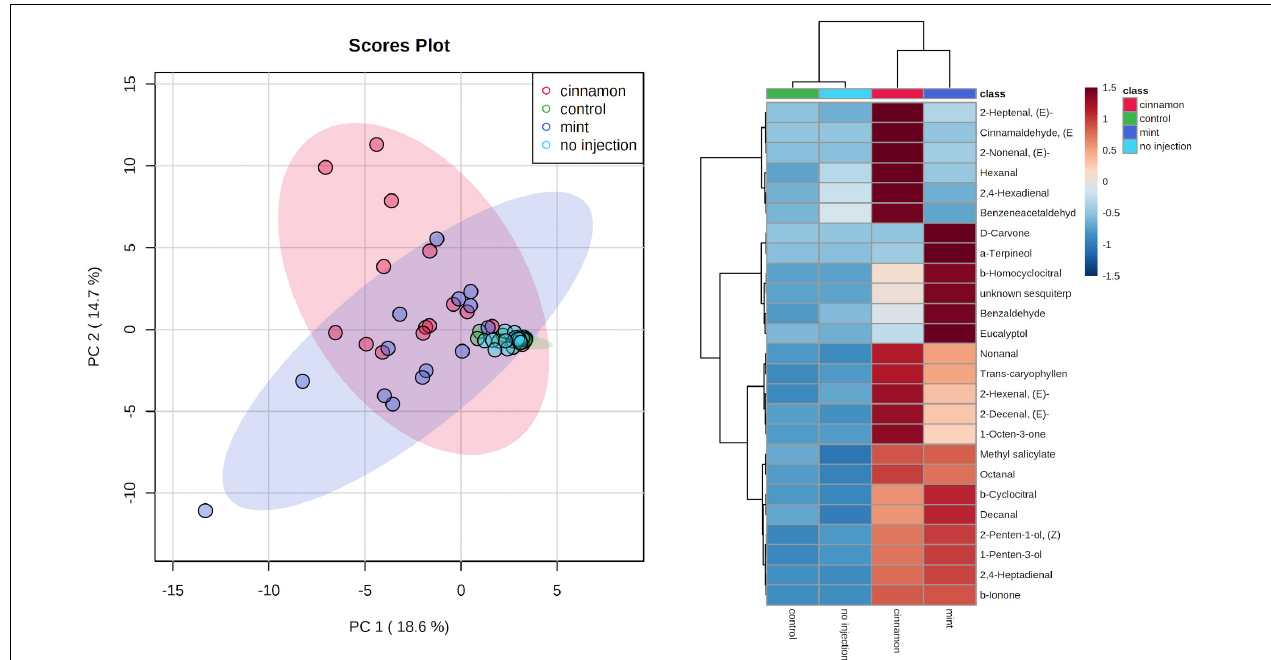
FIGURE 7 | Principal component analysis (PCA) (left) and heatmap of top 25 contributors merged by group (right) of Malus domestica volatile organic compounds (VOCs) contained generated on metaboanalyst software after data centring processing.